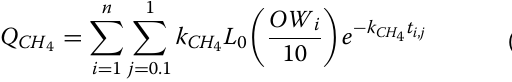
/t biodegaradable waste ) for optimizing scenarios of CH 4